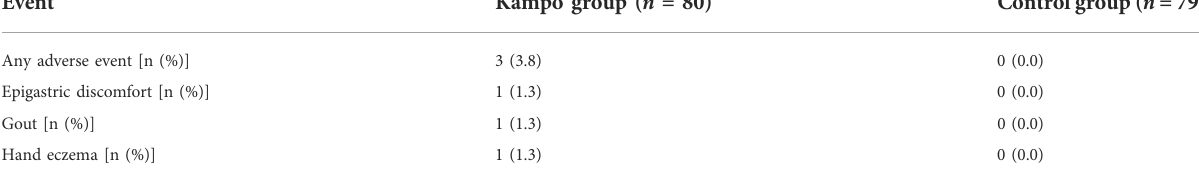
TABLE 4 Adverse